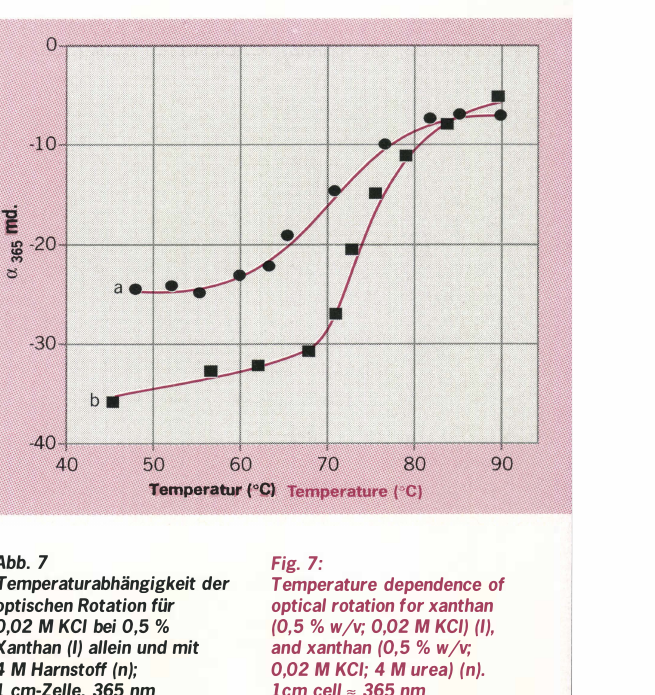
Fig. 7: Temperature dependence of optical rotation for xanthan (0,5 % wjv; 0,02 M KCI) (/), and xanthan (0,5 % wjv; 0,02 M KCI; 4 M urea)